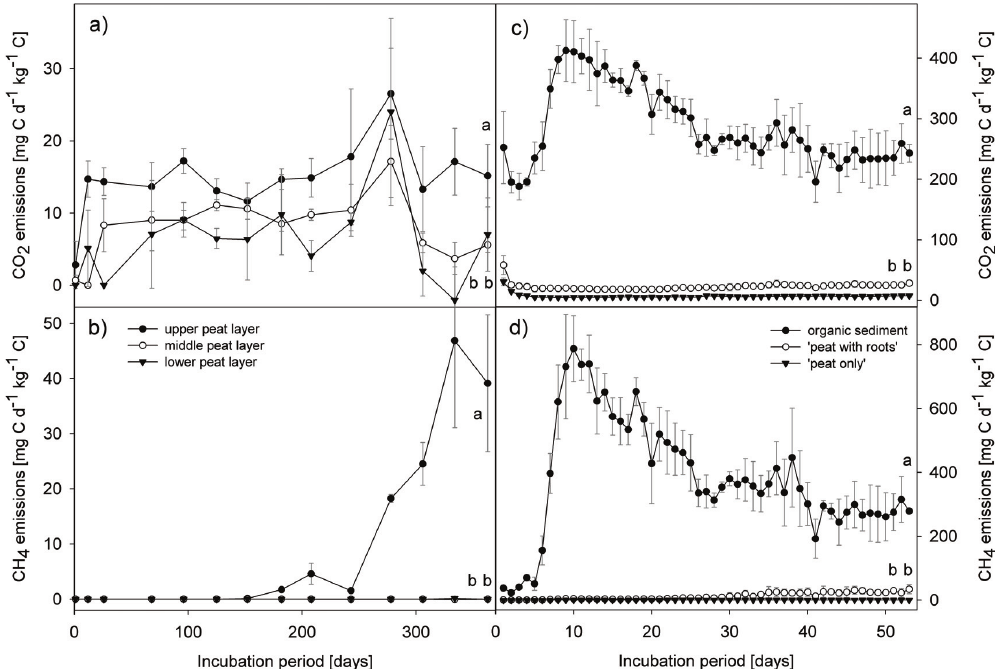
Fig. 1. CO 2 and CH 4 emissions from the surface for the peat layer incubation (a, b) and for the organic substrate incubation (c, d) at constant temperature (20 ◦ C and 15 ◦ C) (mean ± SD, n = 3; different letters on the left indicate significant differences, p < 0 . 001).